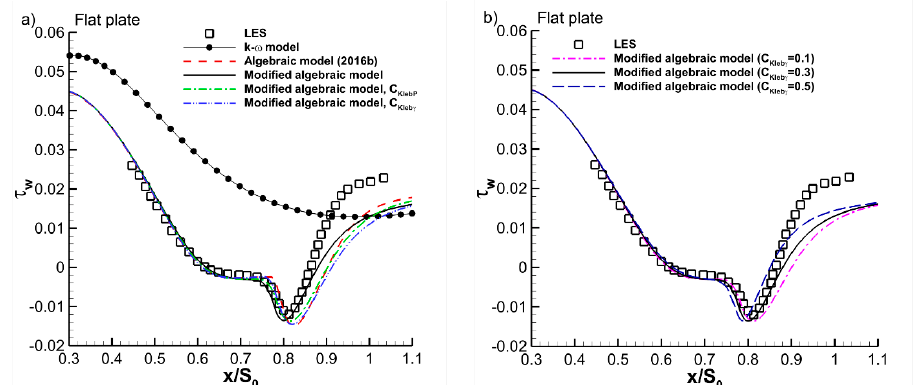
Figure 9. Flat plate by Li and Yang. Wall shear stress along the plate. Verification of the model sensitivity to the terms with C Kleb γ and C KlebP . Results with one extension active in either Equation (7) or Equation (8) ( a ), and results with both extensions active in Equations (7) and (8) (setting different ffi cient) ( b values of the C Kleb γ coefficient) ( b ). values of the C Kleb γ coe